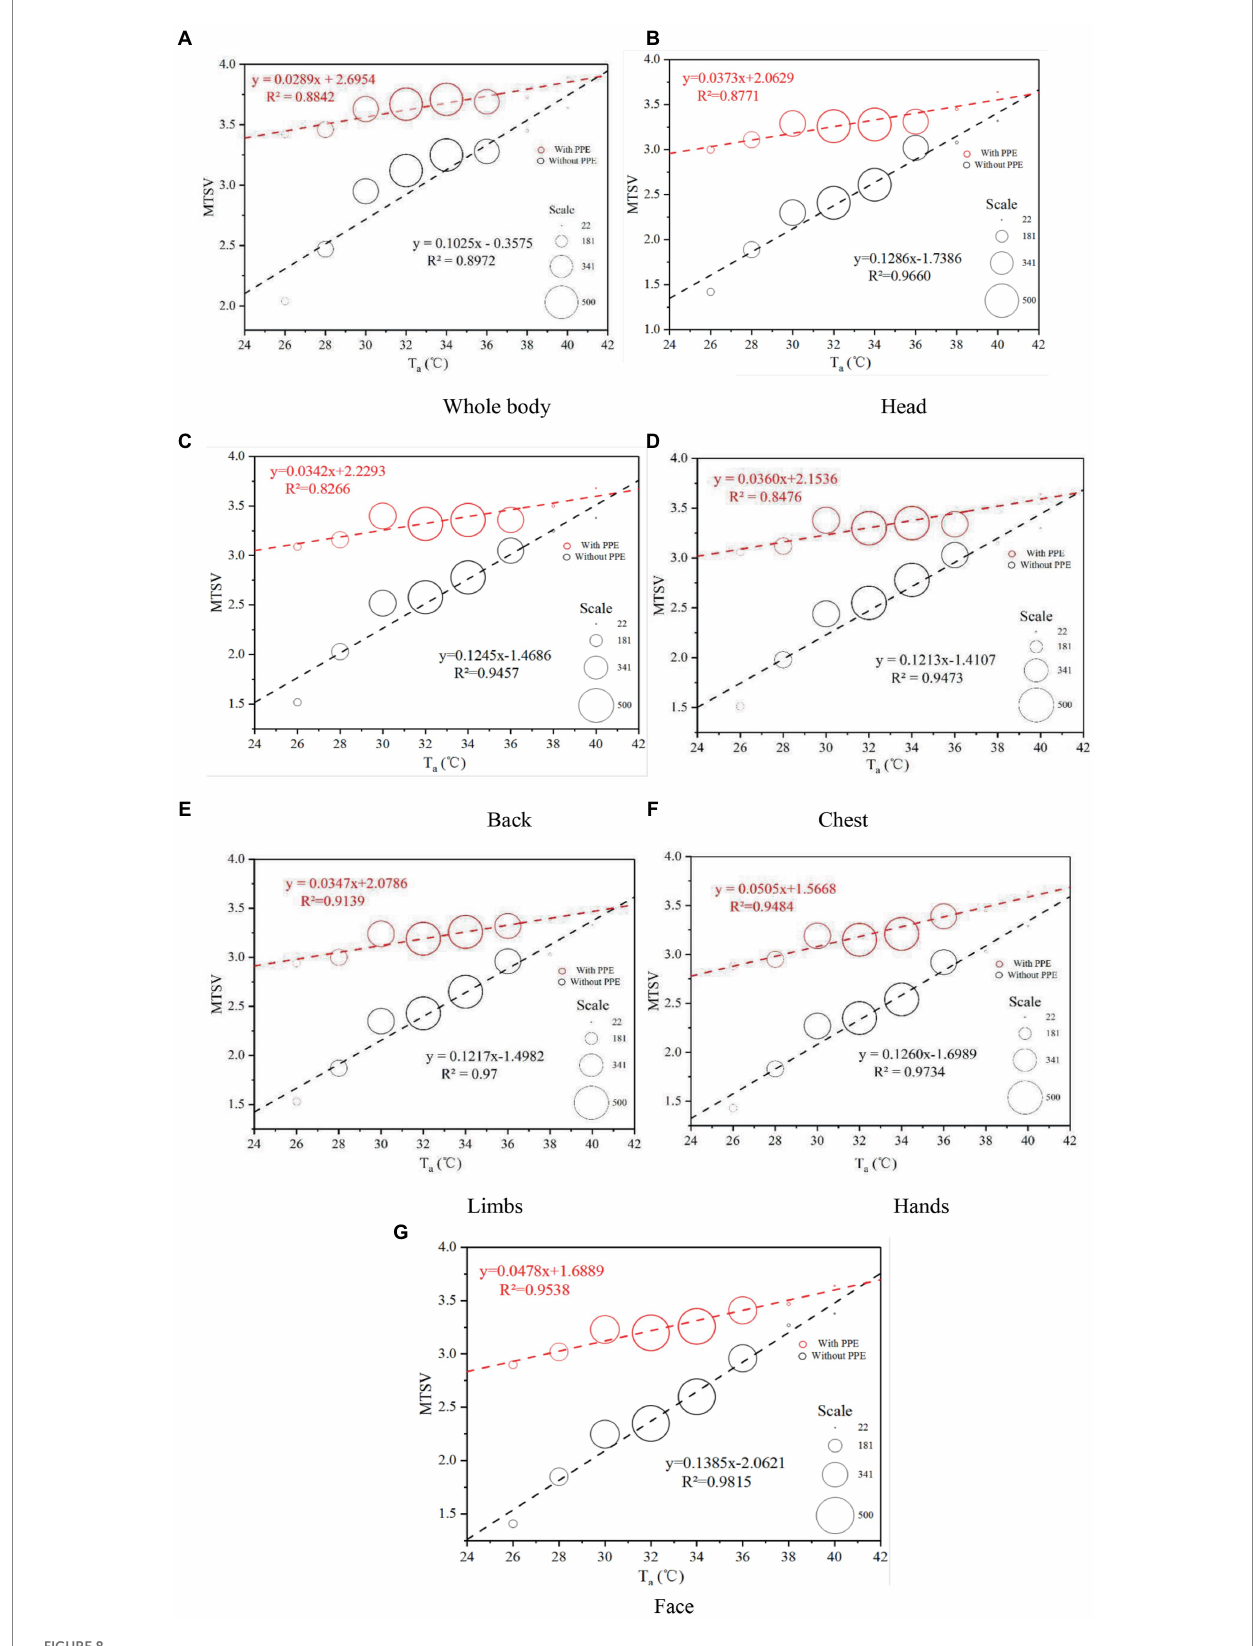
FIGURE 8 Variations in MTSV against T a . PPE, personal protective equipment; MTSV, mean thermal sensation vote; T a , air